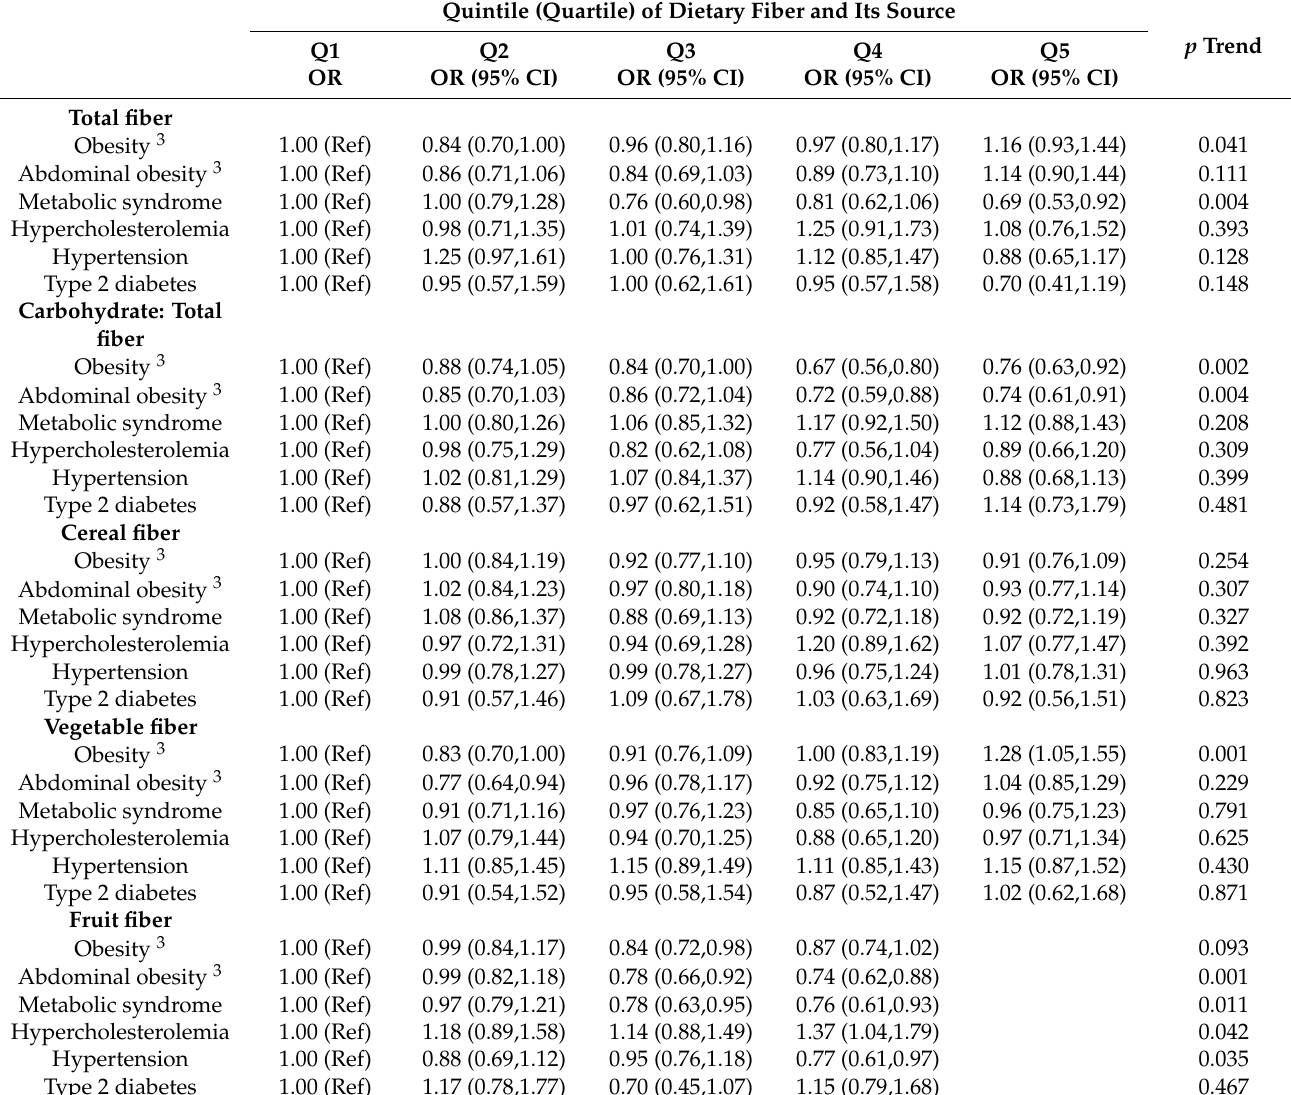
Table 3. Associations of dietary fiber and its source with cardiovascular risk factors among Korean men 1,2 . Quintile (Quartile) of Dietary Fiber and Its